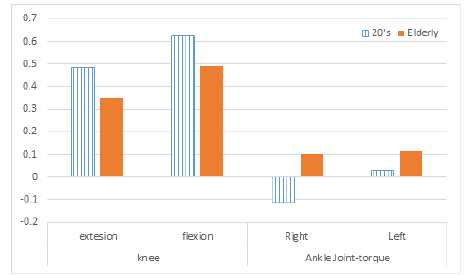
Figure 9. Gait factor.